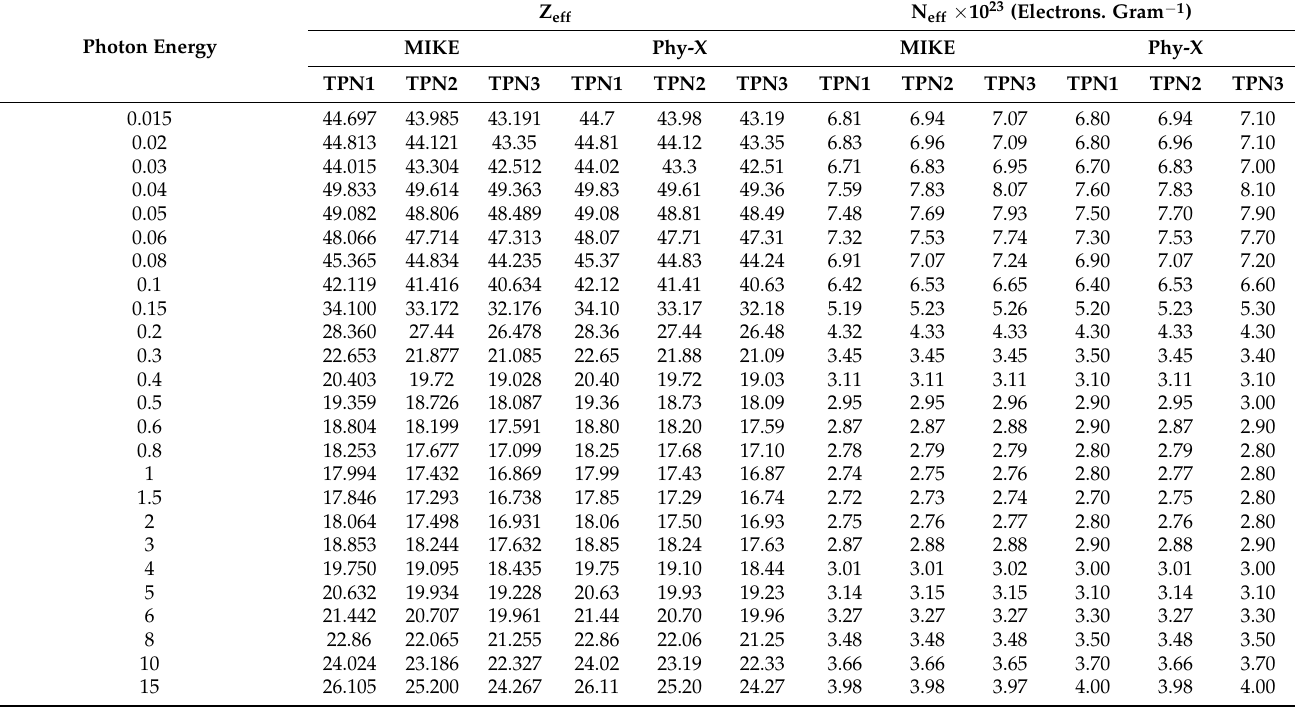
Figure 7. The radiation shielding parameters: ( a ) Effective atomic number (Z eff ); ( b ) Effective electron number (N eff ). Table 5. Effective atomic number and effective electron density values for TNP